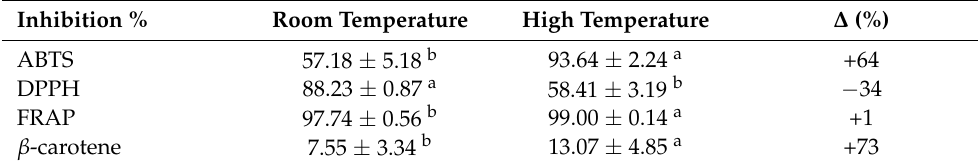
Table 5. Effect of high growing temperature on antioxidant capacity of broccoli